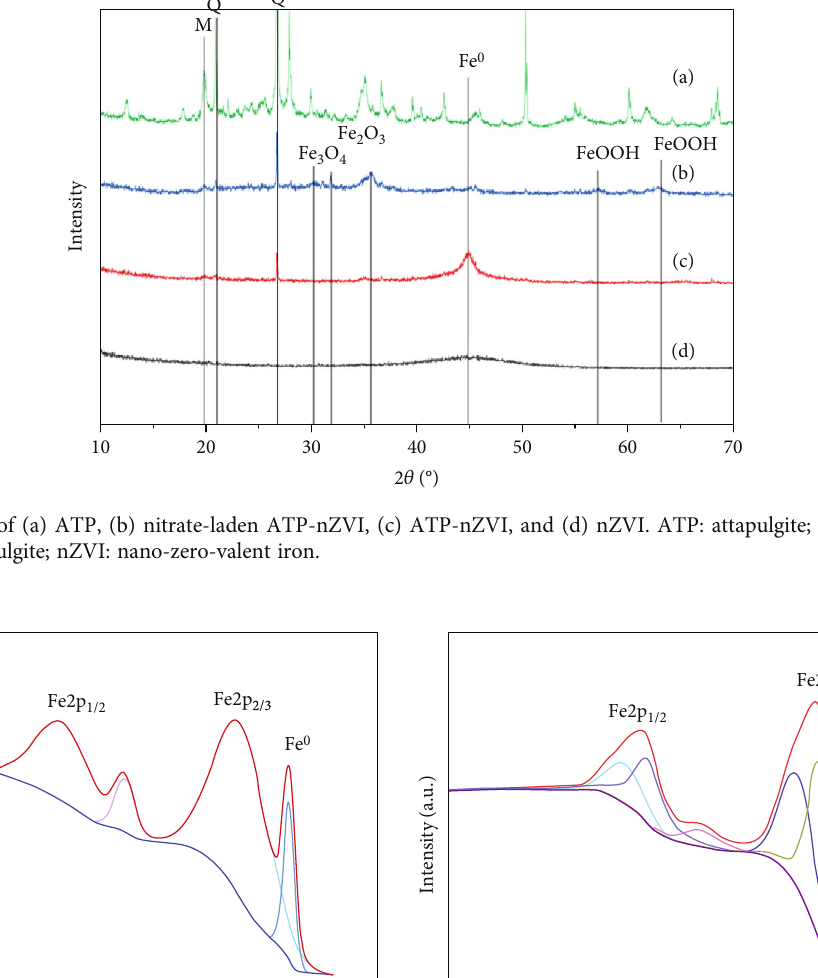
-N removal by ATP-nZVI. ATP-nZVI: nano-zero-valent 3